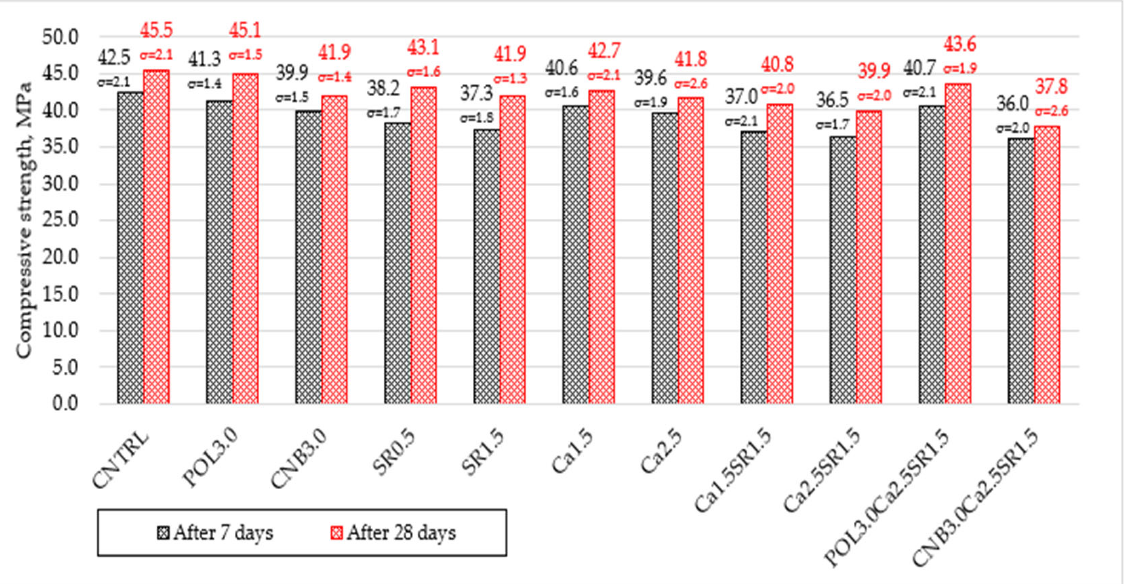
7 and 28 days of hardening. Polypropylene fiber slightly reduces the strength of concrete